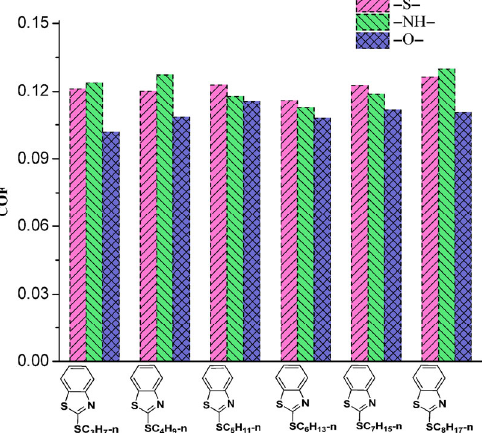
Fig. 17 The friction coefficient when lubricating with thioben- zothiazole compounds and their isosteres in bis(2-ethylhexyl) adipate.